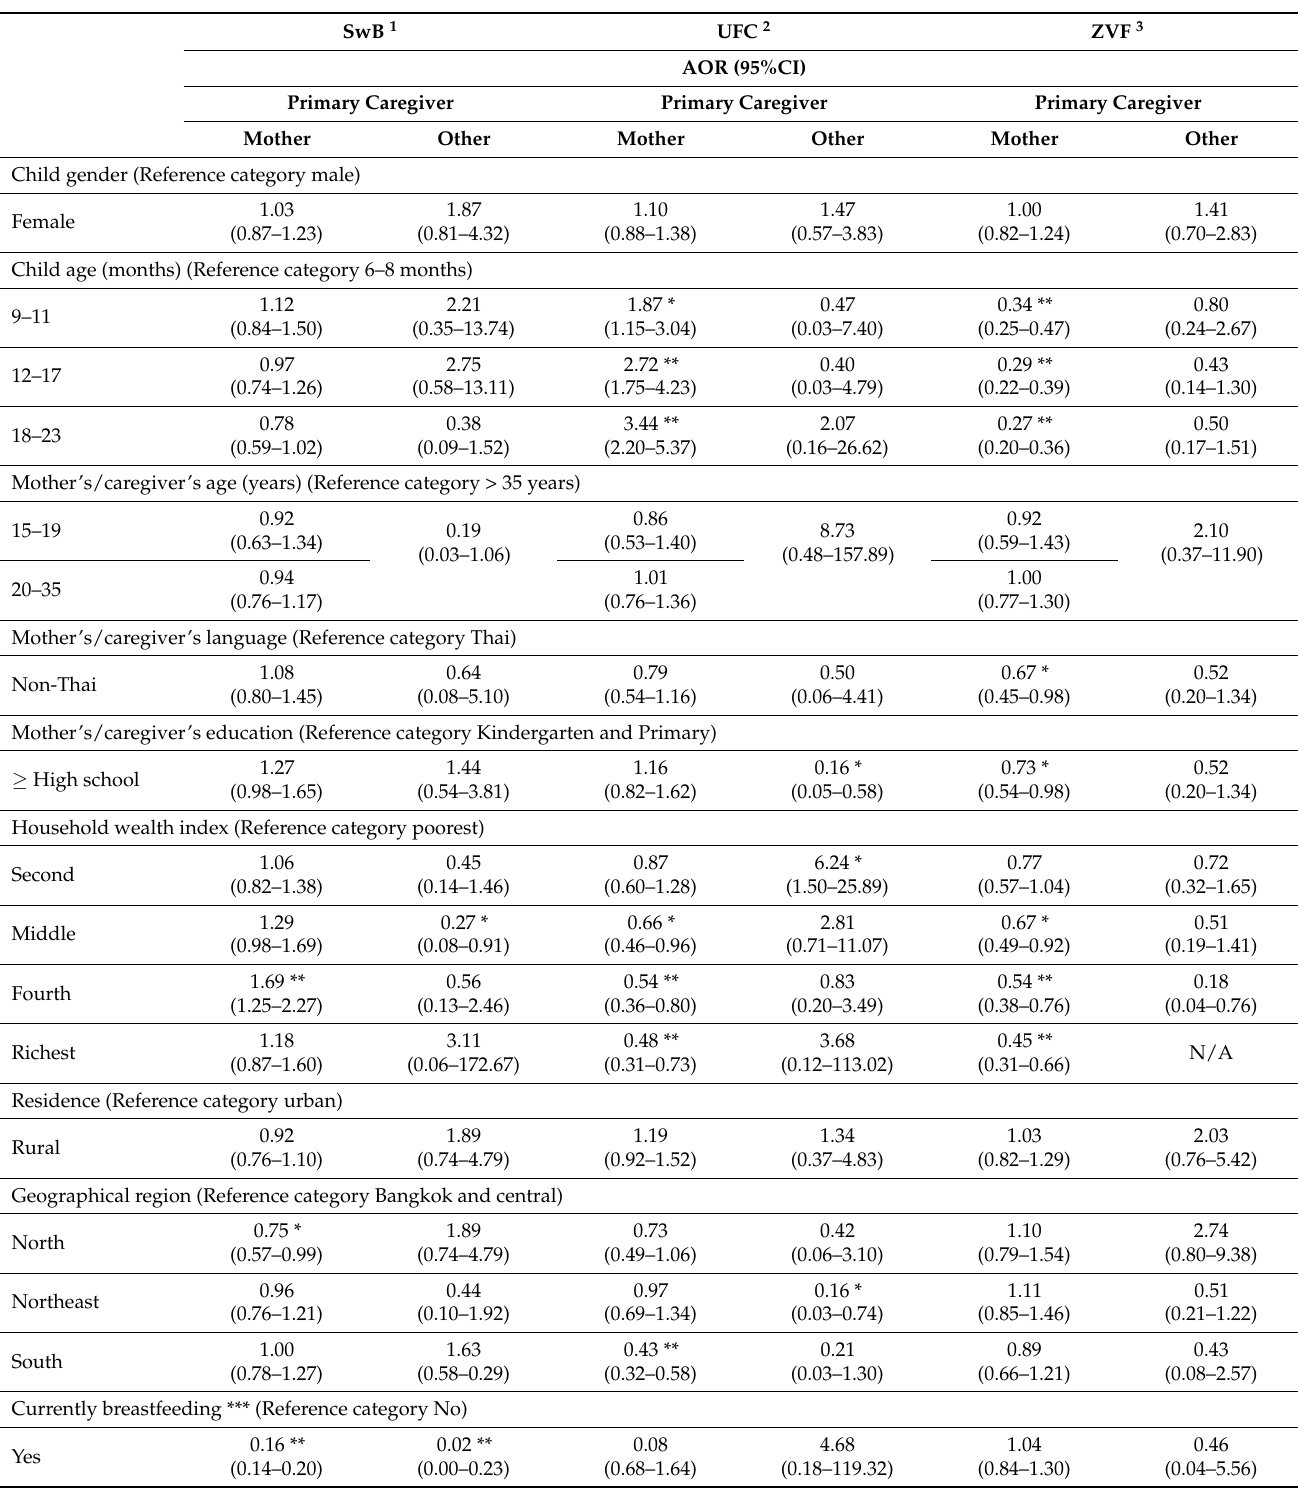
Table 5. Factors associated with complementary feeding indicators, SwB, UFC, ZVF, the multivariate logistic regression